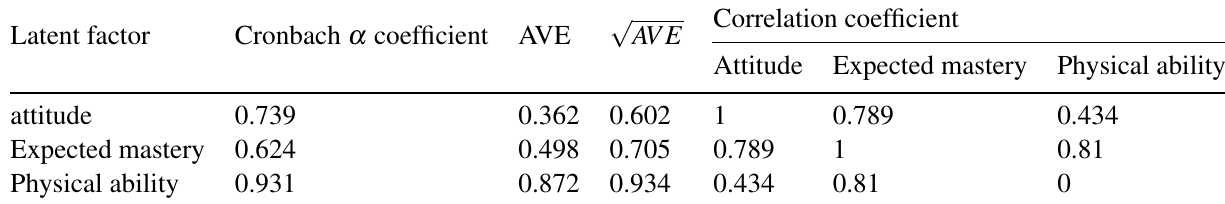
Table 5 Reliability and validity test indicators.